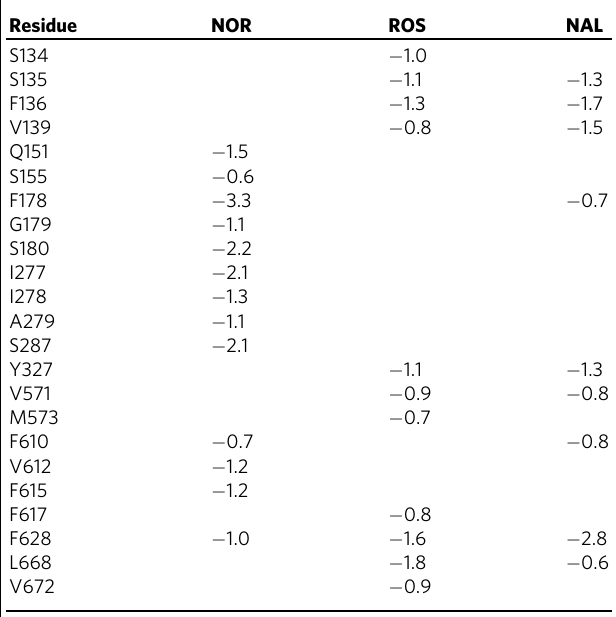
Table 4 Per-residue contribution to the binding free energy (kcal.mol − 1